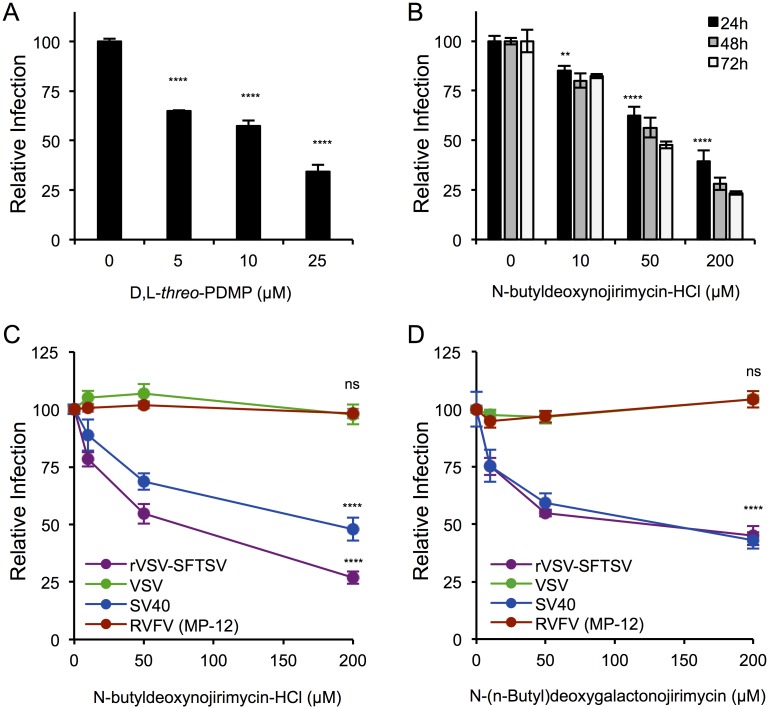
Pharmacological inhibitors of UGCG activity inhibit rVSV-SFTSV entry.(A) A549 cells were pre-treated with the UGCG inhibitor D,L-threo-PDMP for 24 hours before infection with rVSV-SFTSV. Drug was kept in the media throughout the infection. Ten hours post-infection cells were harvested, immunostained for VSV M, and analyzed by flow cytometry. Mean ± S.E.M. for 3 independent experiments. (B) A549 cells were pre-treated with the UGCG inhibitor N-butyldeoxynojirimycin-HCl (NB-DNJ) for 24, 48, or 72 hours before infection with rVSV-SFTSV. Drug was kept in the media throughout the infection. Ten hours post-infection, cells were harvested, immunostained for VSV M, and analyzed by flow cytometry. Mean ± S.E.M. for 3 independent experiments. (C,D) A549 cells were pre-treated with NB-DNJ (C) or N-(n-Butyl) deoxygalactonojirimycin (NB-DGJ) (D) for 48 hours before infection with rVSV-SFTSV, VSV, SV40, or RVFV. Drug was kept in the media throughout infection. Ten hours (rVSV-SFTSV, VSV, RVFV) or 24 hours (SV40) post-infection, cells were harvested, immunostained for viral antigen, and analyzed by flow cytometry. Mean ± S.E.M. for 3 independent experiments. **** p<0.0001 using Student’s t-test with Bonferroni correction.